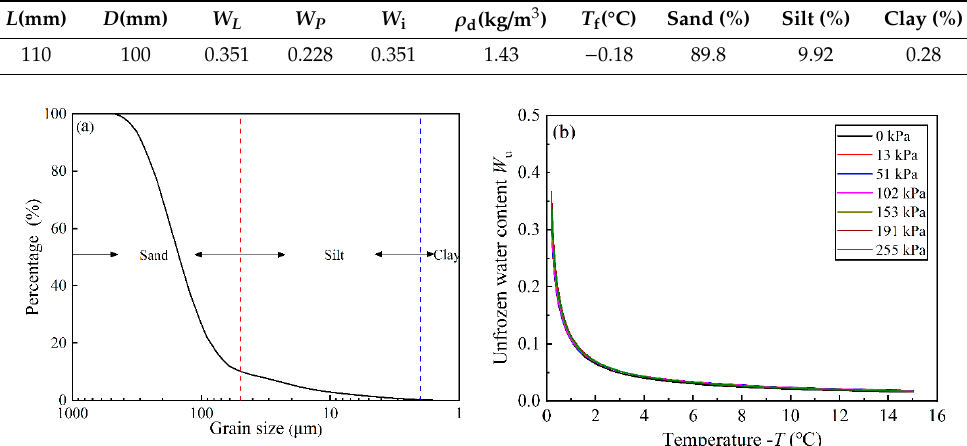
Figure 2. ( a ) Accumulative curve of particle size grading of soil samples, ( b ) soil freezing characteristic curve of soil